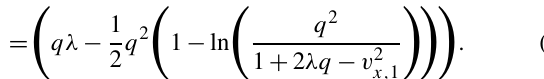
Figure 3. Streamlines with (cid:49)ψ = 0 . 1 (cid:49)ψ wake and isobars with (cid:49)p = 0 . 1 (cid:49)H for (cid:49)H/ ( 1 the wake axis are not plotted. Ticks at the axes are at a 1 R